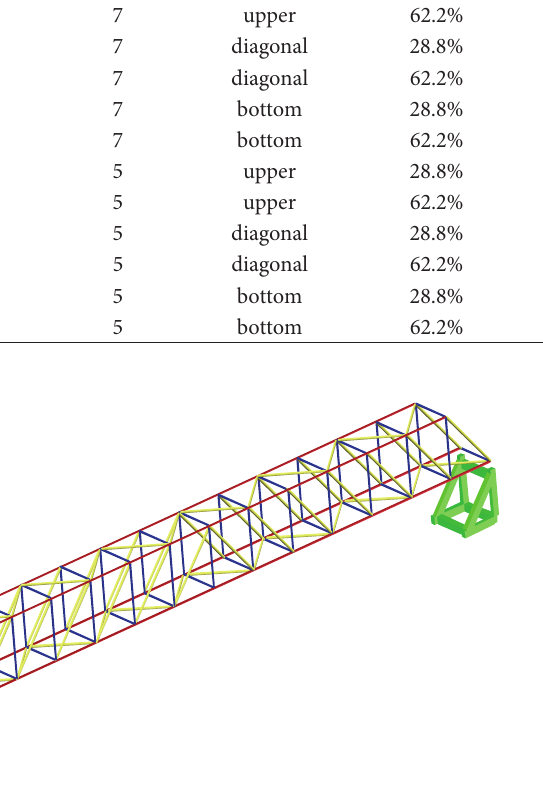
Figure 3: Test structure FE